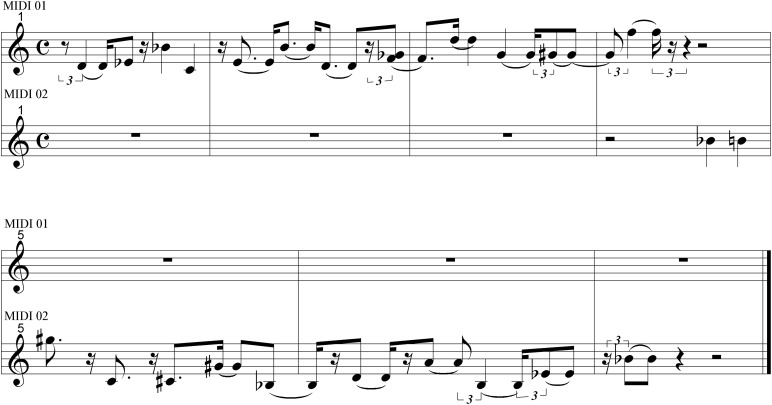
A simple melody (top stave) is continued by the Continuator in the same style (as in Addessi and Pachet, 2005, p. 23).